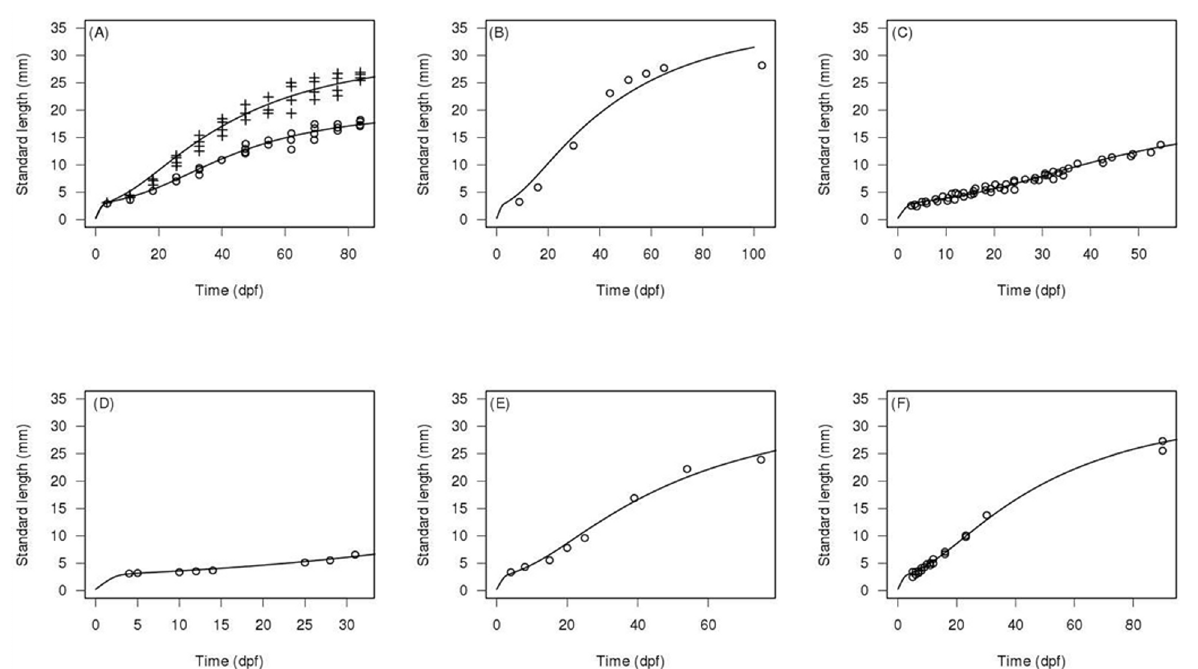
Fig 4. DEB model simulations against observed length for fish from various literature experiments. All lengths are presented as standard length (mm). Circles and crosses represent observations, lines represent model predictions. Panel A represents dataset from Lawrence et al. [31], experimental temperature (T exp ) of 28.5°C, estimated ingestion level ( f ) of 0.54 (circles) and f = 0.80 (crosses). Panel B represents dataset from G ò mez-Requeni et al. [33], T exp = 28°C, f = 0.96. Panel C represents dataset from Schilling [30], T exp = 28°C, f = 0.52. Panel D represents dataset from Bagatto et al. [29], T exp = 25°C, f = 0.86. Panel F represents dataset from Best et al. [32], T f = 0.87 f = 0.47. Panel E represents dataset from Eaton and Farley [28], T exp = 25.5°C, exp = 25°C,